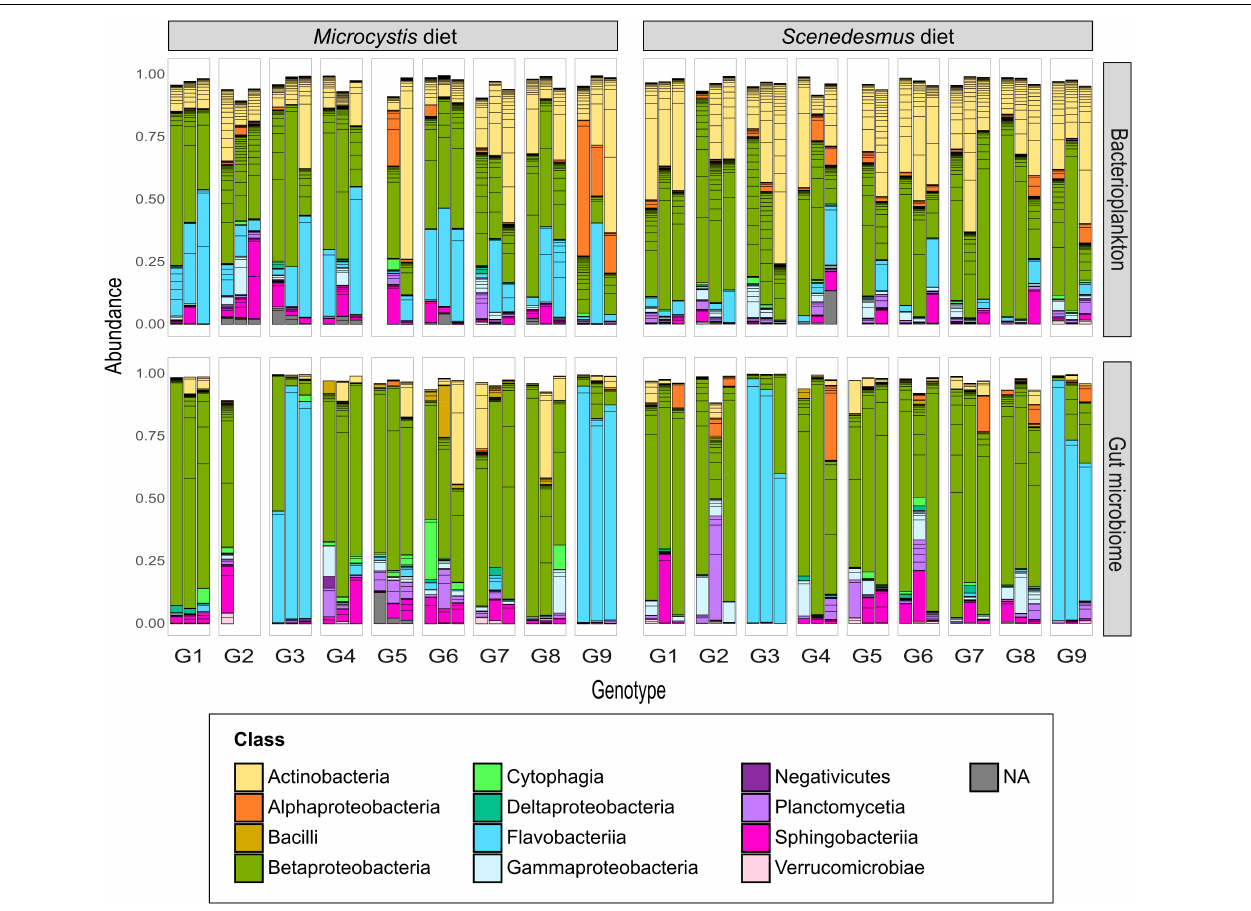
FIGURE 1 | BPK and GM composition across Daphnia genotypes and diets (Experiment 1). Nine Daphnia genotypes (G1–G9) were exposed to either a Microcystis or a Scenedesmus diet. After 58 generations of exposure, both Daphnia GM and BPK were characterized through next generation sequencing ( n = 3 replicated populations per genotype × diet combination). Bars indicate the relative abundance of OTUs. Colors indicate bacterial classes. OTUs with an occurrence lower than 1% are not